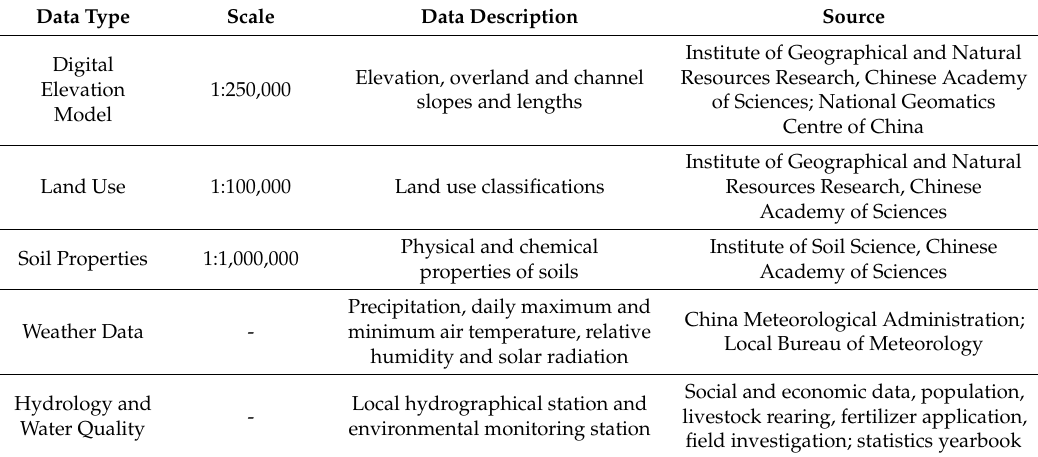
Table 1. Description of data available for the Sanjiang